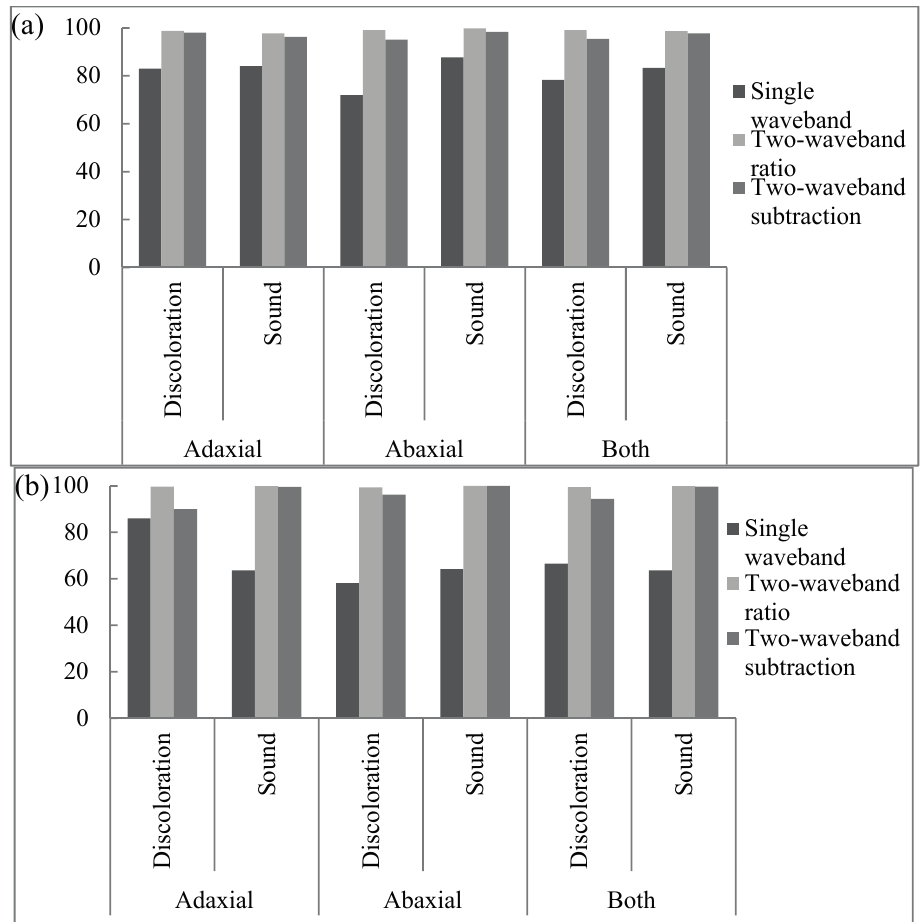
Figure 4. Classification accuracy of adaxial surface, abaxial surface and both surfaces using a single waveband algorithm and a combination of a two-waveband algorithm and pixel spectra: ( a ) calibration (Set A) and ( b ) validation (Set